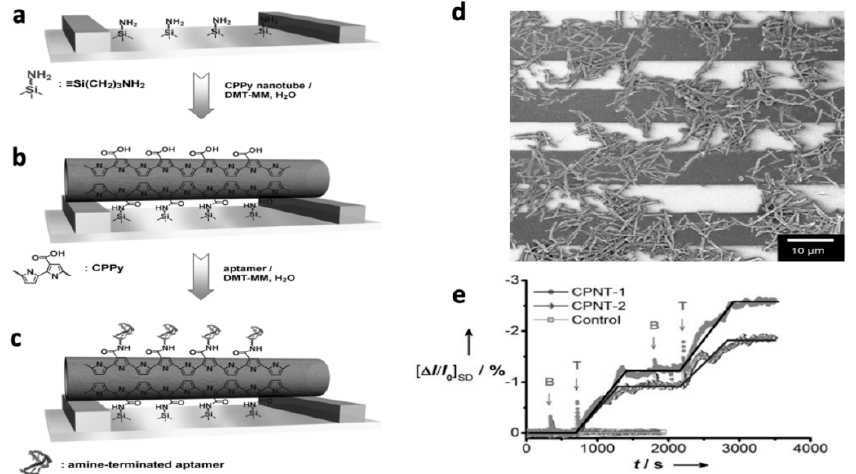
Figure 21. Thrombin sensors are fabricated as shown: ( a ) The interdigitated microelectrodes of the FET gate are treated with aminosilane. ( b ) Immobilization of the CPPy-NTs onto the substrate via amide linkages induced with the condensing agent 4-(4,6-dimethoxy-1,3,5-triazin-2-yl)-4-methylmorpholinium chloride (DMT-MM). ( c ) Thrombin aptamers are bonded to the CPPy-NTs via amide linkages. ( d ) SEM image of CPPy-NTs deposited onto the interdigitated microelectrode substrate. ( e ) Sensing ability of the CPPy-NT FET sensors. Real-time responses of CPPy nanotube FET sensors measured at a source-drain voltage of − 15 mV (CPNT-1, circles) and − 10 mV (CPNT-2, diamonds): current changes are apparent upon consecutive additions of a 90 nM target (thrombin, T) and nontarget (BSA, B) protein solutions added at times indicated by the arrows. No change in current occurred when the aptamer-free control CPPy-NT FET was used (squares) [104]. Reprinted from ChemBioChem , Vol. 9, H. Yoon, J. Kim, N. Lee, B. Kim, and J. Jang, “A Novel Sensor Platform Based on Aptamer-Conjugated Polypyrrole Nanotubes for Label-Free Electrochemical Protein Detection,” pp. 2634–641, Copyright 2008 Wiley-VCH Verlag GmbH & Co. KGaA, Weinheim.